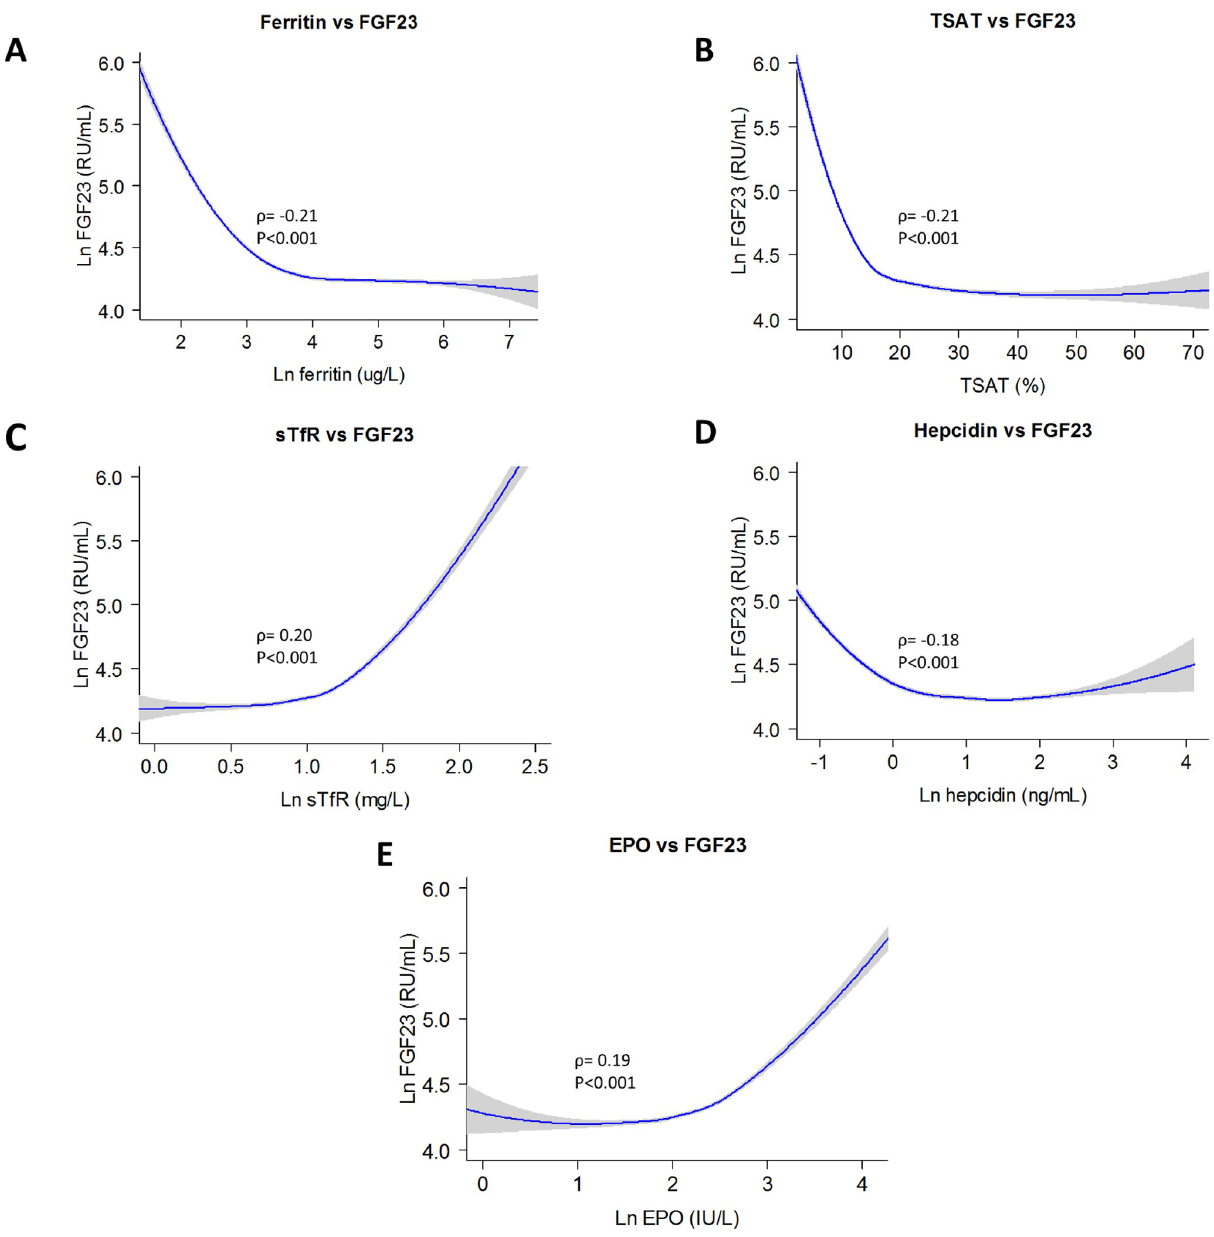
Fig 1. Cross-sectional associations of iron status parameters and EPO with FGF23. Plots were generated with use of locally weighted scatterplot smoothing and show the association of FGF23 with ferritin (Panel A), TSAT (Panel B), sTfR (Panel C), hepcidin (Panel D), and EPO (Panel E). Lines and band represent means and 95% CIs, respectively. CI, confidence interval; FGF23, ferritin, sTfR, hepcidin, and EPO were naturally log transformed. EPO, erythropoietin; FGF23, fibroblast growth factor 23; sTfR, soluble transferrin receptor; TSAT, transferrin saturation.